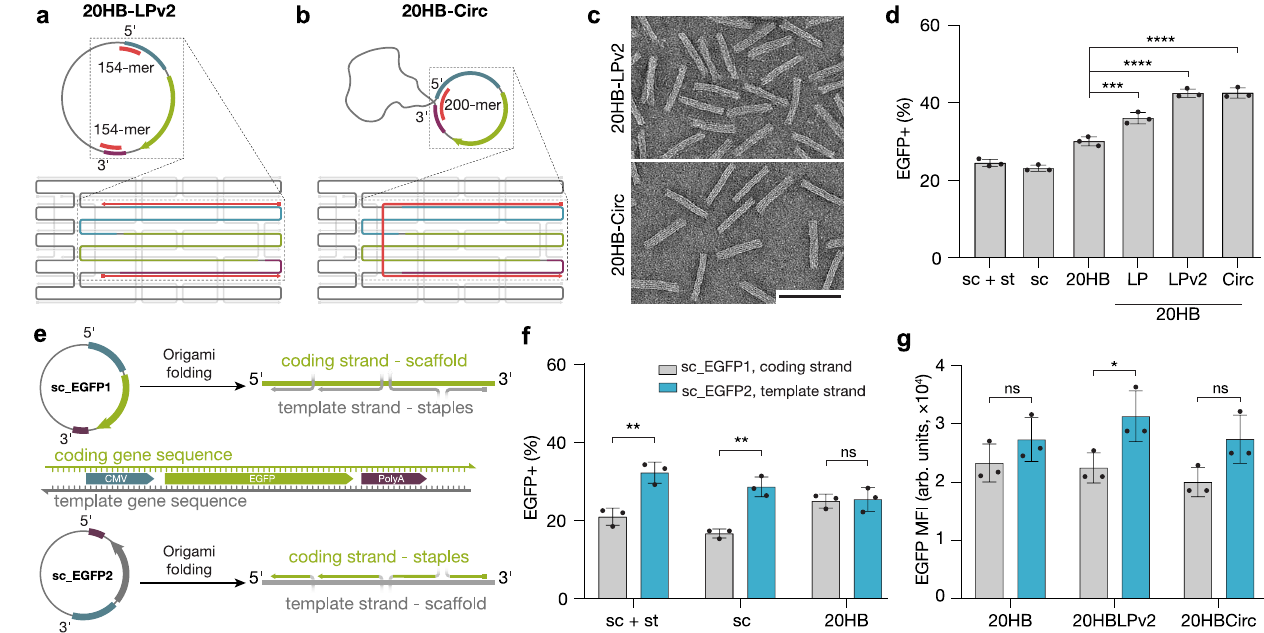
Fig. 2 | Optimization of gene expression through staple design and scaffold orientation. Scaffold routing and schematics of unfolded scaffold for 20HB-LPv2 and 20HB-Circ designs, a and b respectively. 20HB-LPv2 incorporates two con- tinuous 154-mer staples (pink), and 20HB-Circ design has been routed so that the 200-merstaple(pink),whichactsasasplint,bringstogetherthe5 ’ startoftheCMV, and the 3 ’ ofthe polyA. c TEM micrographs of 20HB-LPv2 and 20HB-Circ, scalebar 100nm. d Transfection ef fi ciency into HEK293T cells via electroporation revealed higher transfection ef fi ciency for samples 20HB-LP ( p =0.00004), 20HB-LPv2 ( p =1.87×10 − 7 ) and 20HB-Circ ( p =1.82×10 − 7 ), when compared to the standard 20HB. e Scaffold used encoded for the ‘ coding strand ’ , where the expression cas- sette is present in the 5 ’ to 3 ’ direction (sc_EGFP1, upper panel). Scaffold encoding for the reverse complementary sequence of the expression cassette, thus the ‘ template strand ’ (sc_EGFP2, lower panel) was designed and produced. f Transfection ef fi ciency into HEK293T cells by electroporation with